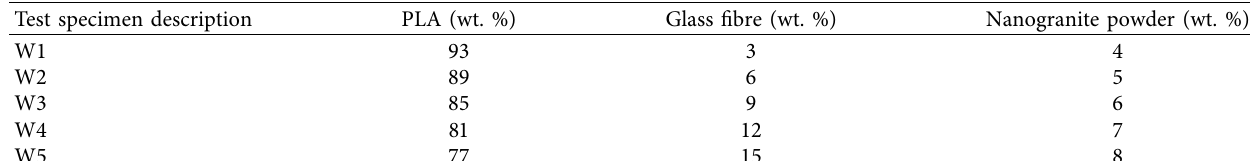
Table 3: Compositions of each prepared sample.